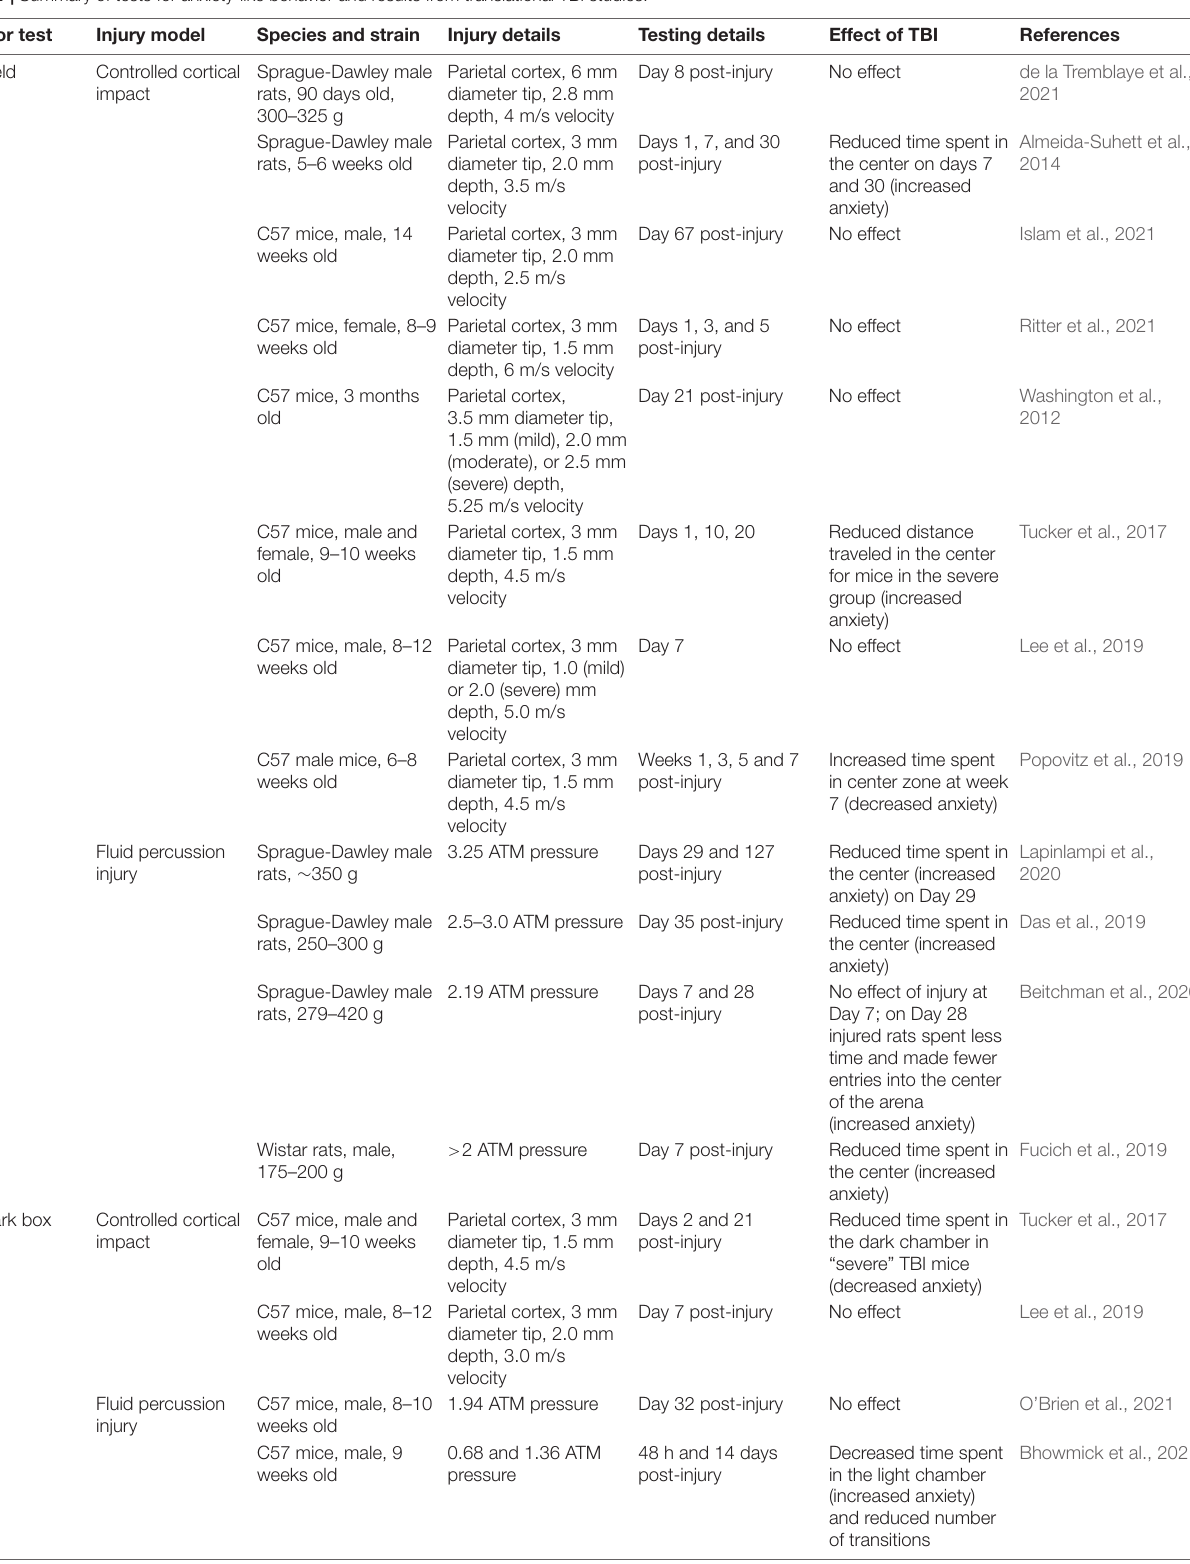
TABLE 1 | Summary of tests for anxiety-like behavior and results from translational TBI